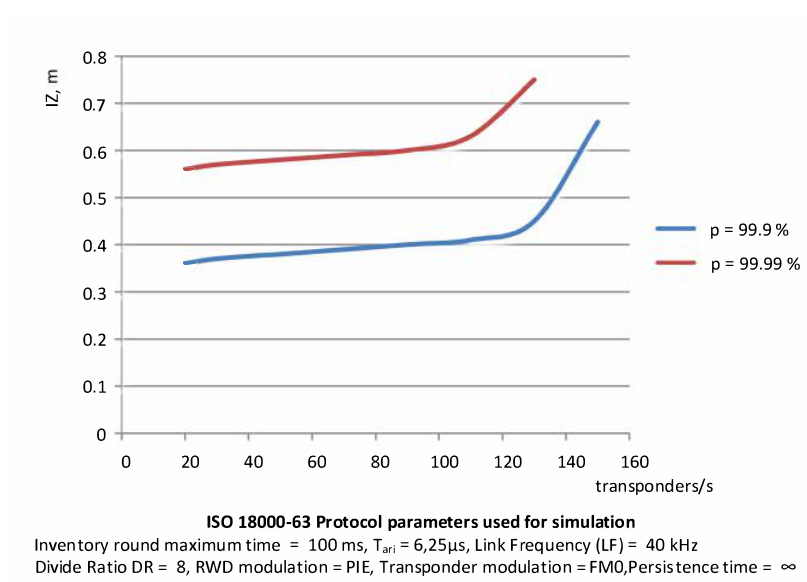
Figure 16. Determination of the interrogation zone depending on the number of transponders at assumed probability levels.